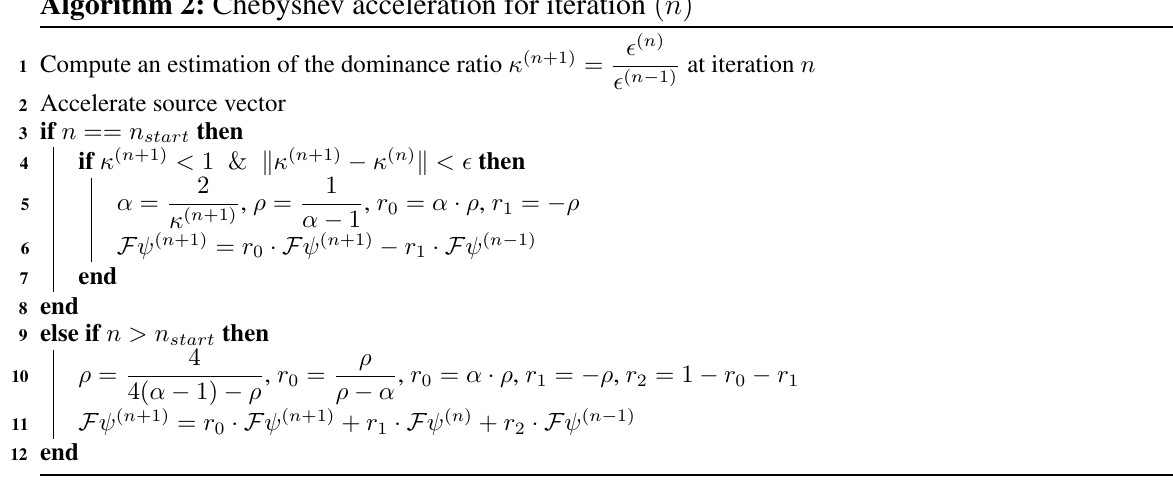
Algorithm 2: Chebyshev acceleration for iteration ( n